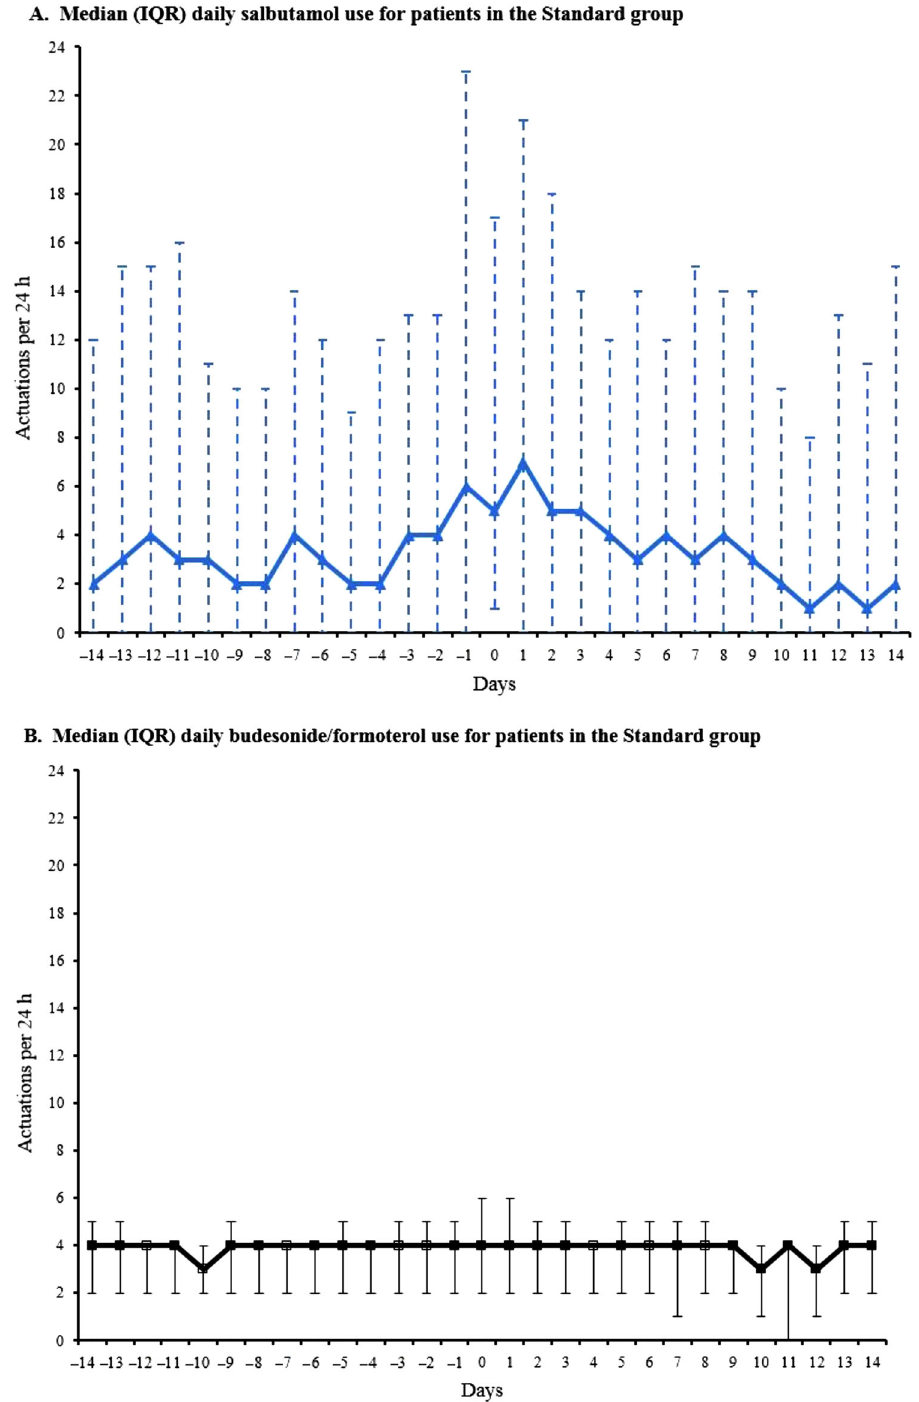
Fig. 3 Median (IQR) daily salbutamol a and budesonide/formoterol b actuations in the 14 days prior to, and the 14 days following a severe exacerbation in the Standard group. Day 0 represents the initiation of corticosteroid therapy. There were 66 severe exacerbations in the Standard group. For patients with repeat exacerbations, a minimal interval of 28 days between exacerbations was required, to avoid overlap of data within the same participant. Three patients in the Standard group had repeat severe exacerbations occurring within 28 days following the prior exacerbation. In another patient randomised to Standard treatment, there was no recorded data for two severe exacerbations due to use of non-study inhaled medication. Thus, electronic data for 61 severe exacerbations were included in the plots of medication use patterns in the Standard group. For these plots, only one of the included days (2 days prior to severe exacerbation for a patient in the Standard group) met dose dumping criteria ( ≥ 100 actuations in a 3 h